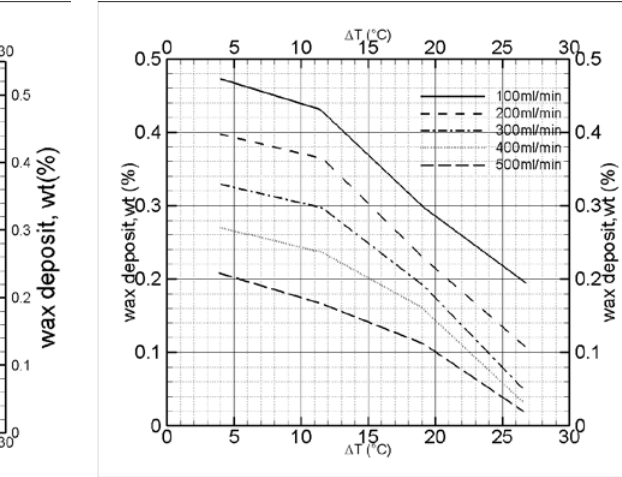
Figure 2 Effect on wax deposit (weight percentage) due to temperature differential at 6min (kelechukwu et al., 2010)